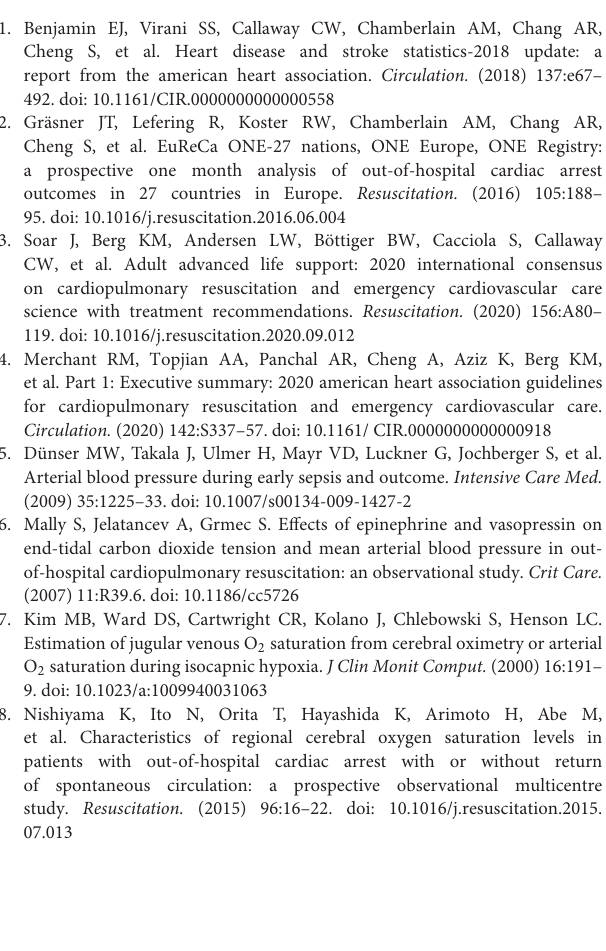
Supplementary Figure 1 | (A) Scatterplot of MAP and rSO 2 of each time point. (B) Scatterplot of SAP and rSO 2 of each time point. MAP, mean arterial pressure; rSO 2 , regional oxygen saturation; SAP, systolic arterial